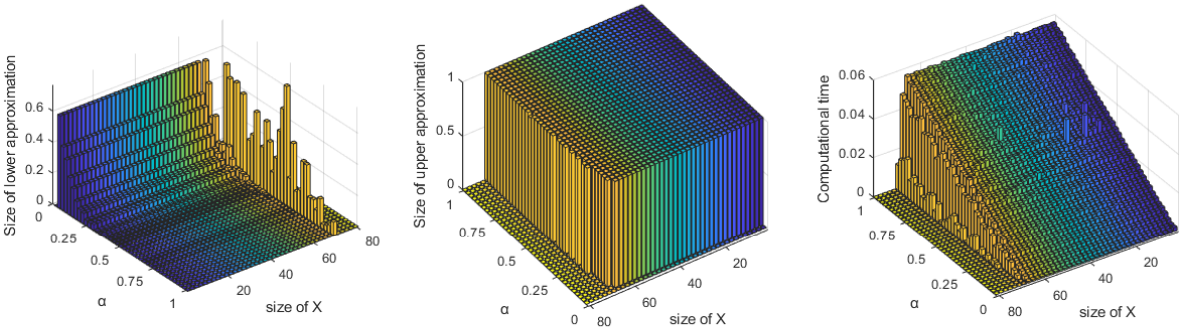
Figure 4. The effluence of α on the lower approximation, the upper approximation and the computa- tional